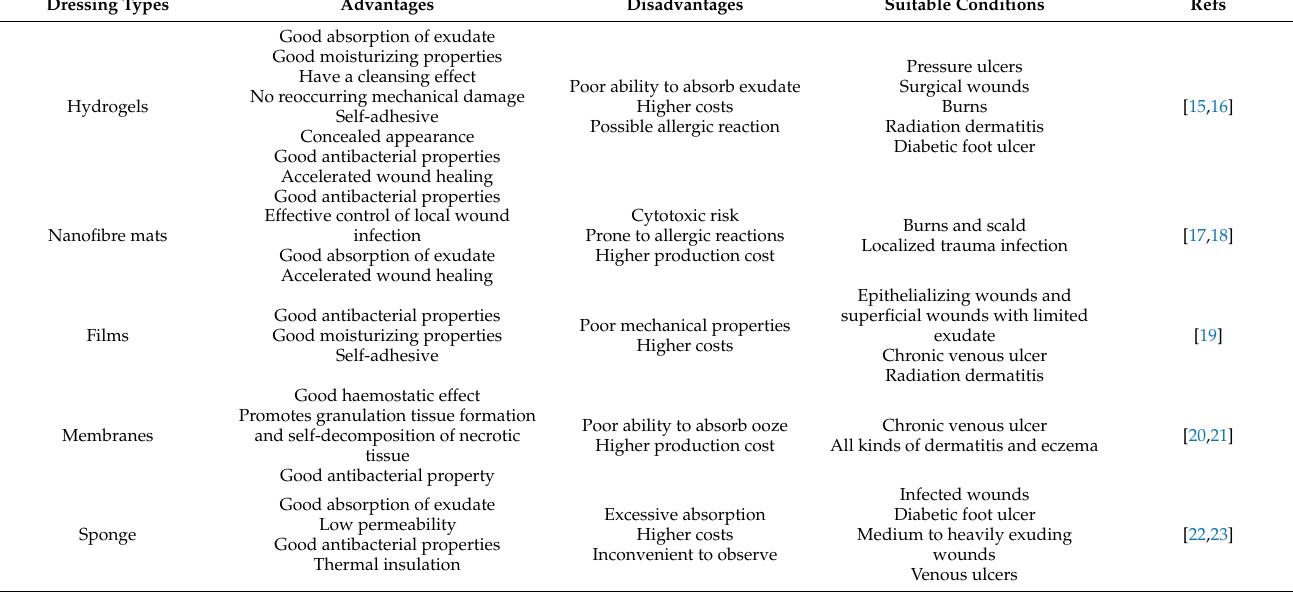
Figure 1. The four processes of wound healing. Table 1. Advantages, disadvantages, and the suitable conditions of dressing forms in modern medicine. Dressing